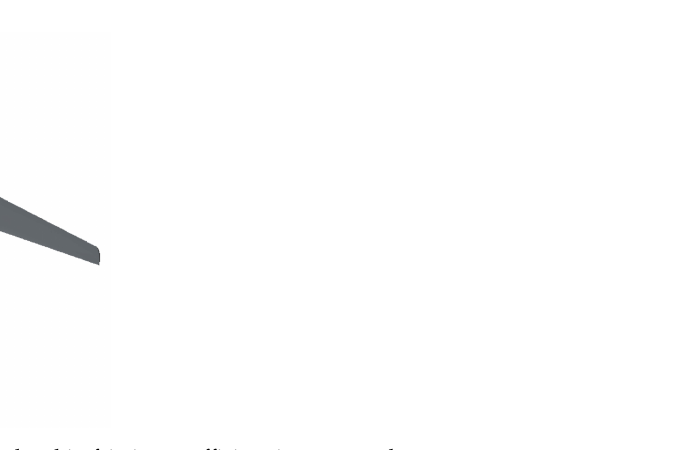
Figure 25. Positions where the skin friction coefficient is measured.